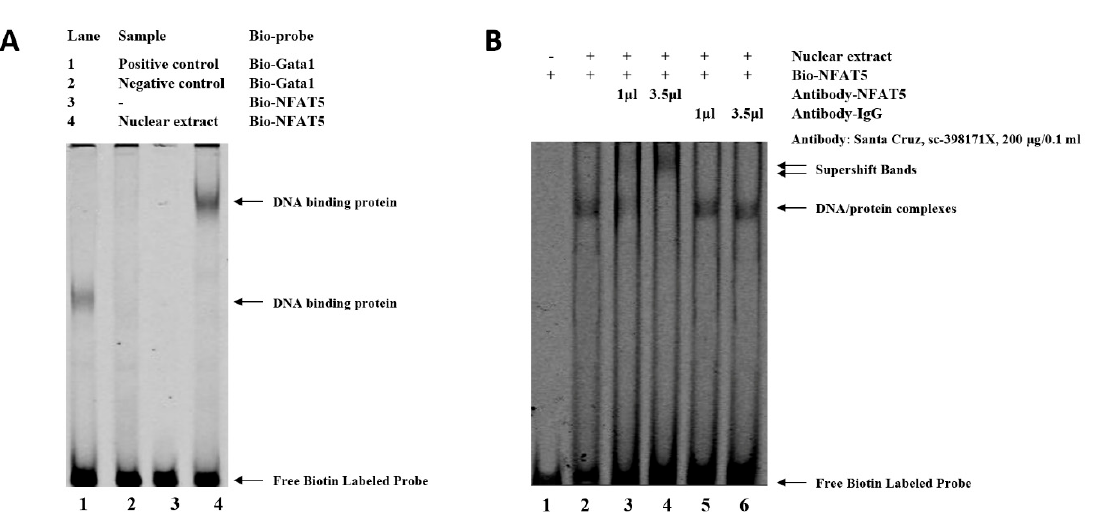
Figure 4. Electrophoretic mobility shift assay (EMSA) of the transcription factor binding sites at the SNP (g. − 3015) in chicken WNT4 promoter. ( A ) EMSA analysis was conducted with biotin-labeled probe in the SNP (g. − 3015). Lane 1 and 2, positive or negative control. Lane 3 and 4, labeled probe without or with nuclear extract. ( B ) Super shift assay with NFAT5 monoclonal antibody appeared to correspond to the DNA-protein-antibody complex. Lane 1, labeled probe without nuclear extract. Lane 2, labeled probe with nuclear extract. Lane 3 and 4, labeled probe with nuclear extract + low or high dose of specific antibody (NFAT5). Lane 5 and 6, labeled probe with nuclear extract + low or high dose of nonspecific antibody (IgG).